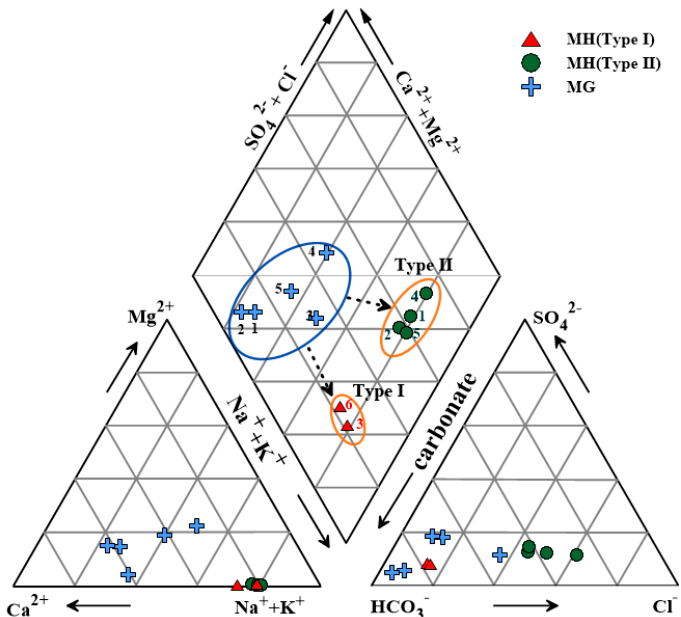
Figure 6. Piper diagram of the major chemical compositions of thermal waters (MH: filled triangles and circles) and groundwater (MG: blue pluses) expressed in milli-equivalent percentages. See Section 4.1 for details.